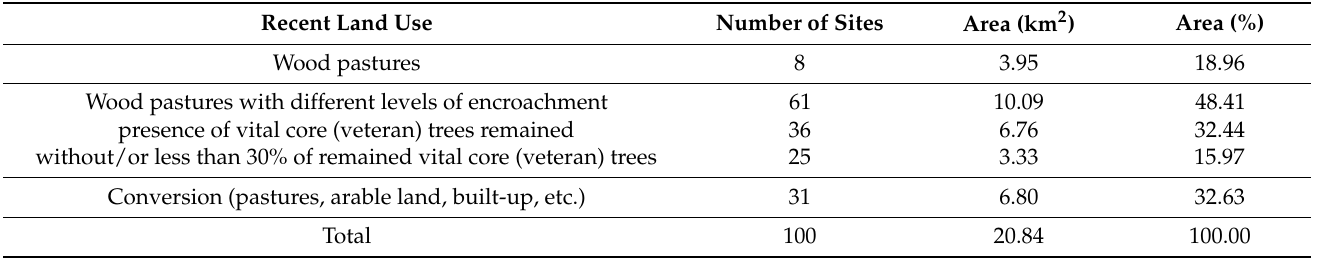
Table 1. Land-use change of wood pastures in the period 1950–2021 in the study area expressed as km 2 and percentage of total wood-pasture